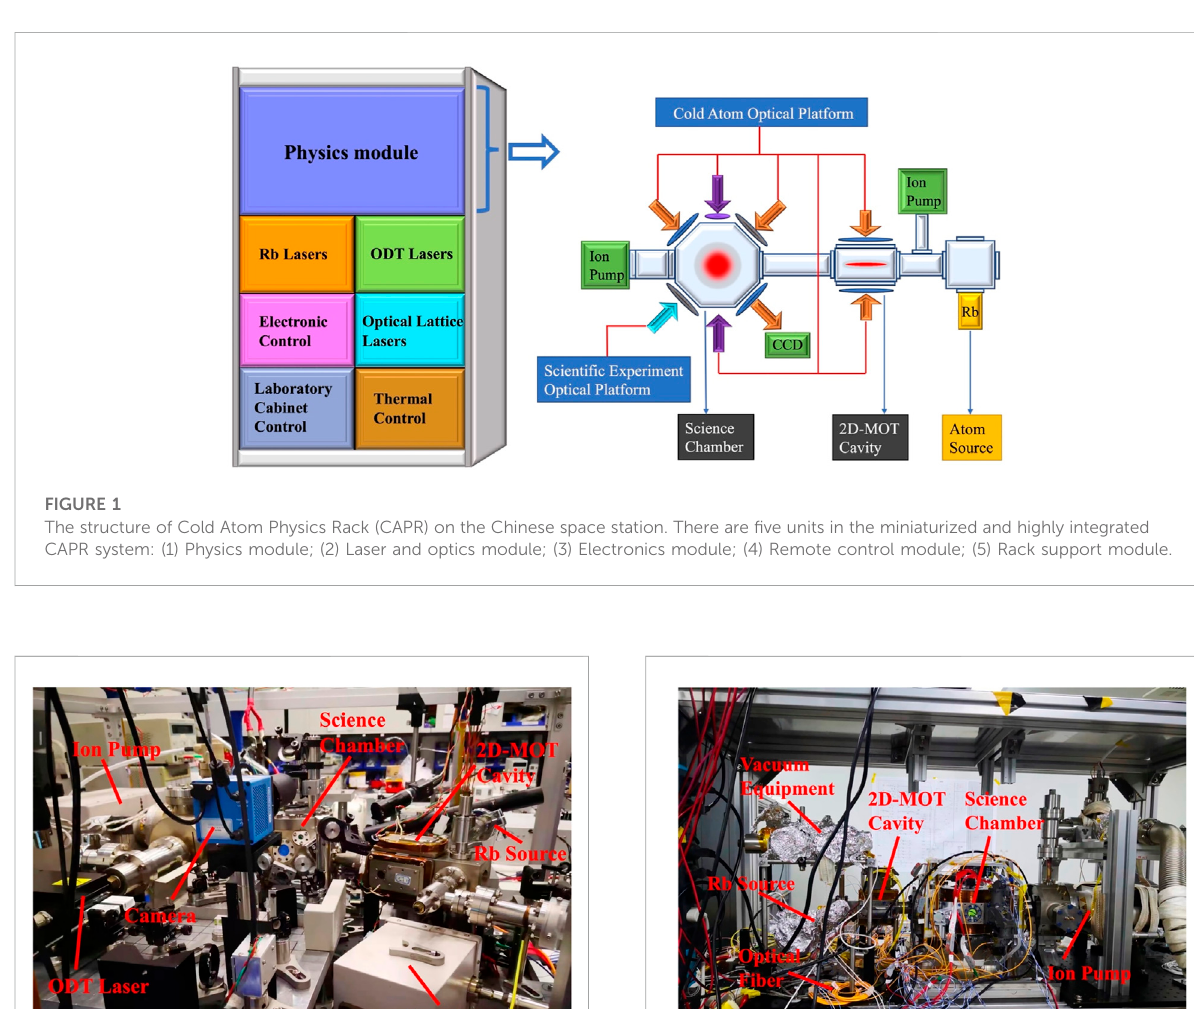
FIGURE 2 Ground principle prototype for CAPR. The purpose of the ground principle prototype is to verify that some technical solutions adopted on CAPR are available.